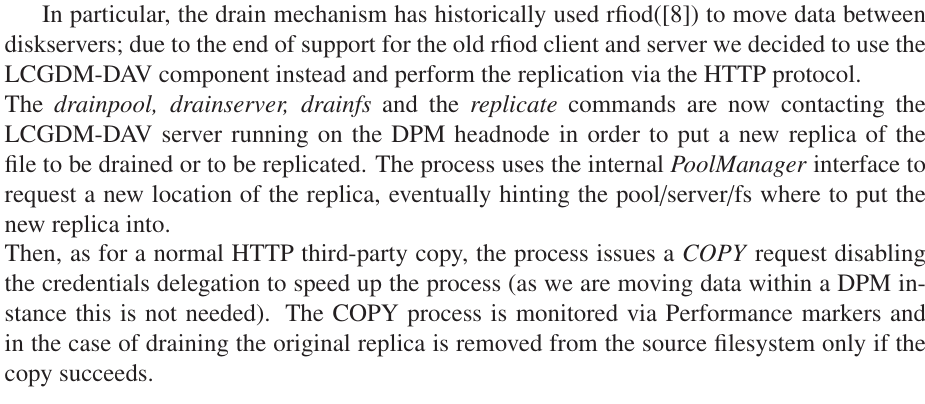
Figure 2. Simplified diagram of DOME in a head